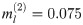
Transition from segregation to strain intermixing.The intermixing of the strains was quantified by heterozygosity H = 〈2f(1 − f)〉, which is nonzero only when both strains are present at the same spatial location. (A,B) show that there is a phase transition between an intermixed regime, where H has a nonzero value at steady state, and a regime, where the strains spatially segregate with H vanishing in the long-time limit. The transition is controlled by the relative magnitude of strain chirality and the strength of genetic drift. The latter depends on the number of the organisms at the growing edge. (C) shows the spatial patterns in the demixed regime starting either from a single boundary or from well-mixed initial conditions. (D) shows how the relative abundance of the strains change starting from well-mixed initial conditions and different initial fractions. Note that, even in the demixed regime, there is negative frequency-dependent selection towards coexistence. (E,F) are the same as (C,D) but in the intermixed regime. All data in this figure are for strains with opposite handedness, but equal magnitude of chirality. Similar results were obtained for unequal magnitudes of chirality; see S4 Fig. Here, m0 = ms = mb = md = 0, g = 0.1 for both strains. In panels (A), (C), (D), (E), (F), ml(2)=0.075, mr(2)=0.025, ml(2)=0.025, mr(2)=0.075 on a lattice of 1000x8000 sites with N = 40 and N = 320 for no intermixing and intermixing respectively. In (B) mr(1)+ml(1)=mr(2)+ml(2)=0.1, N = 200 was held fixed as chirality was varied. All distances were measured in 100 units where Δx = Δy = 1 unit. The right-handed strain is shown in red, and the left-handed strain is shown in green. Note that the equilibration of H requires that f is in steady state; therefore, H equilibrates more slowly.